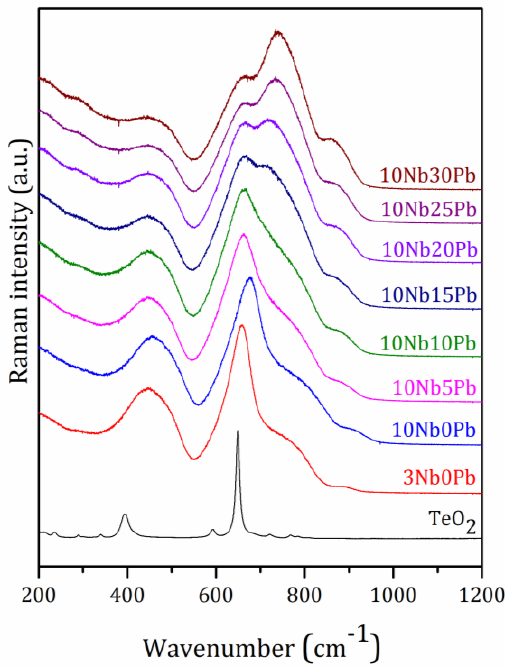
Figure 4. Raman spectra of glass samples in the ternary system (90−x)TeO 2 -10Nb 2 O 5 -xPbF 2